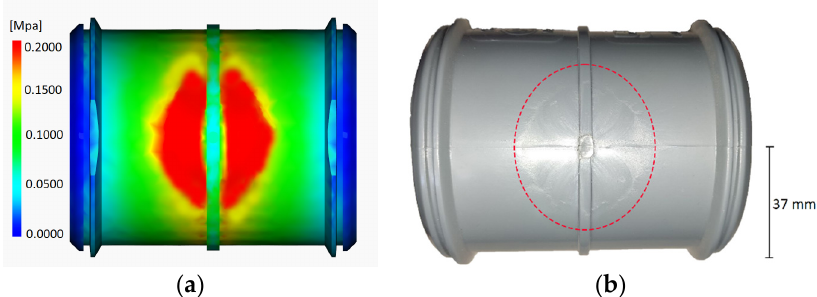
Figure 7. Simulation result ( a ) and enclosed area of defect in the experimental test ( b ) obtained with the same injection molding process settings (melt temperature = 185 °C, mold temperature = 35 °C, flow rate = 25 cm 3 /s, holding pressure = 80 MPa, runner diameter = 10 mm, gate diameter = 3.5 mm, gate angle = 0°, and included angle = 45°).